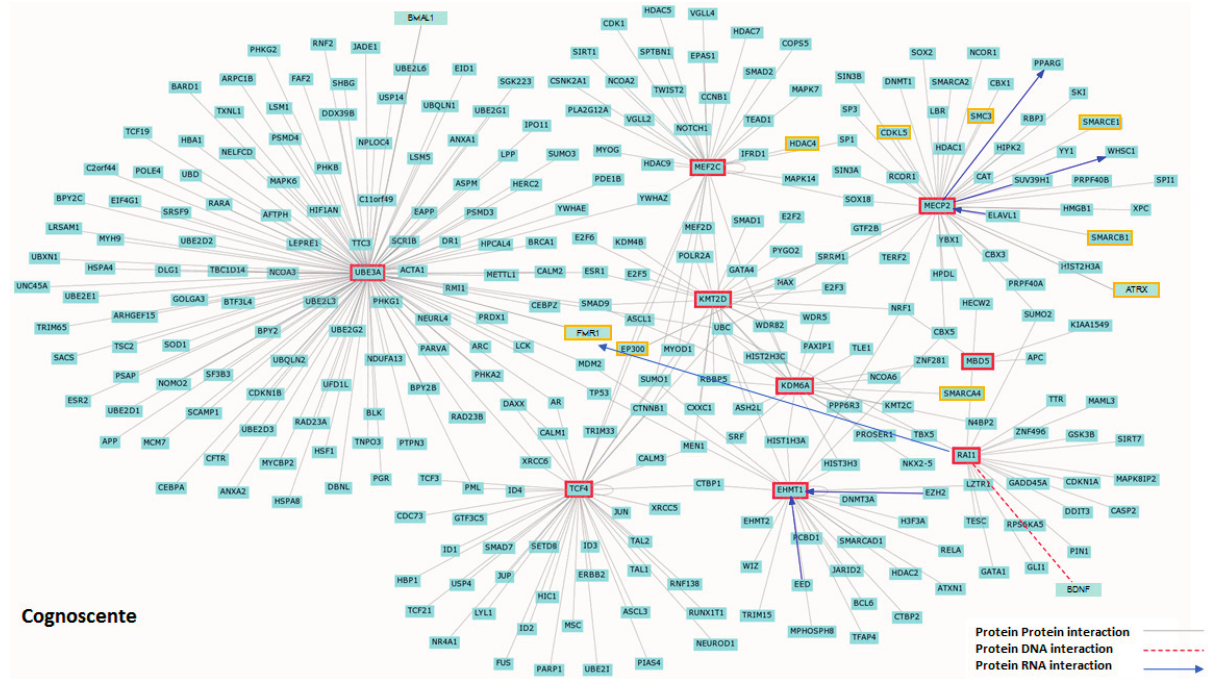
Figure 3. 2q23.1 deletion syndrome gene interaction network. Cognoscente was used to generate direct protein-protein (grey line), protein-DNA (red dash line), and protein-RNA (blue arrow line) interactions of genes previously implicated in ASD: MBD5 , MECP2 , UBE3A , TCF4 , MEF2C , EHMT1 , KMT2D , KDM6A and RAI1 (red box). The